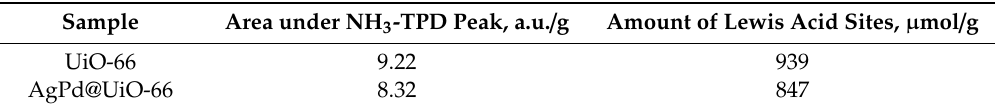
Table 3. Acid properties of UiO-66 and AgPd@UiO-66 (Ag / Pd = 1 / 1, 1%wt. metal loading) prepared by using DS_N 2 H 4.